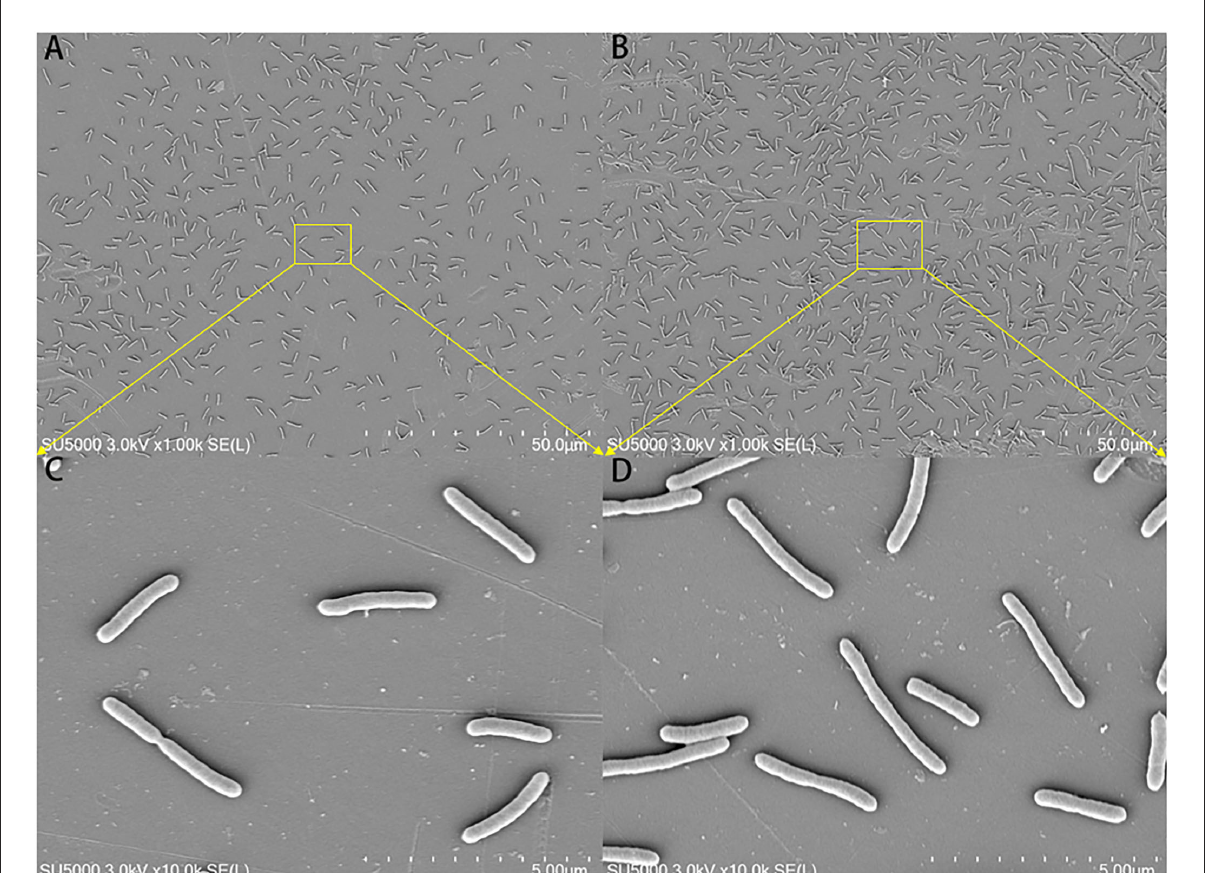
FIGURE3 SEM images of the mature biofilm of S. putrefaciens WS13 under 30 and 4 ◦ C, respectively. The scale bar in (A,B) represents 50.0 µ m. The scale bar in (C,D) represents 5.00 µ